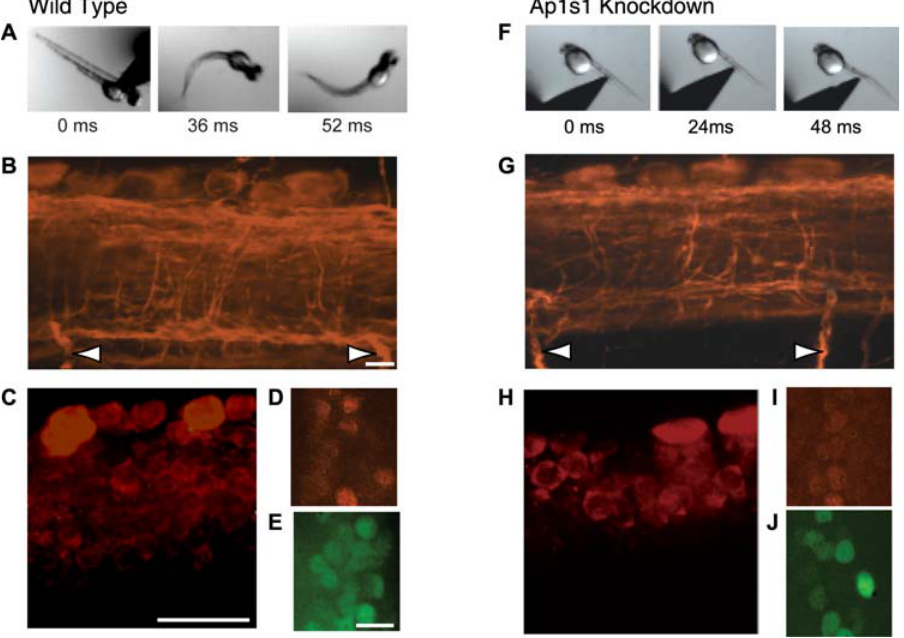
Figure 4. Abnormal behavioral phenotype and impaired development of spinal neural network of Ap1s1 knockdown zebrafish. Consecutive images from films illustrating the response to touch in 48 hpf wild type (WT) (A) and Ap1s1 KD larvae (F). The WT larva reacted to touch by swimming away. In contrast, the Ap1s1 KD larvae exhibit slow and impaired reaction. Immunostaining in wholemount 48 hpf WT (B–E) and Ap1s1 KD larvae (G–J) illustrating the reduced axonal labeling (anti-acetylated tubulin; B and G red, the arrows point to the ventral roots), the reduced number of newly born cells (anti-HU antibody; red in C and H), and the number of interneurons (anti-Pax2 antibody; E and J green) in the Ap1s1 KD larvae. In turn, the number of motoneurons (anti-HB9 antibody; D and I, red) was similar both in WT and Ap1s1 KD. Scale bars: 25 m